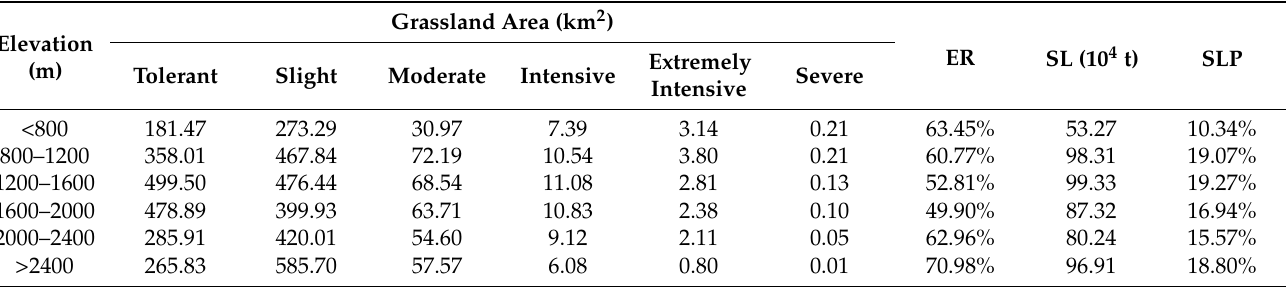
Table 5. Soil erosion intensity grades of grasslands for different elevation zones.